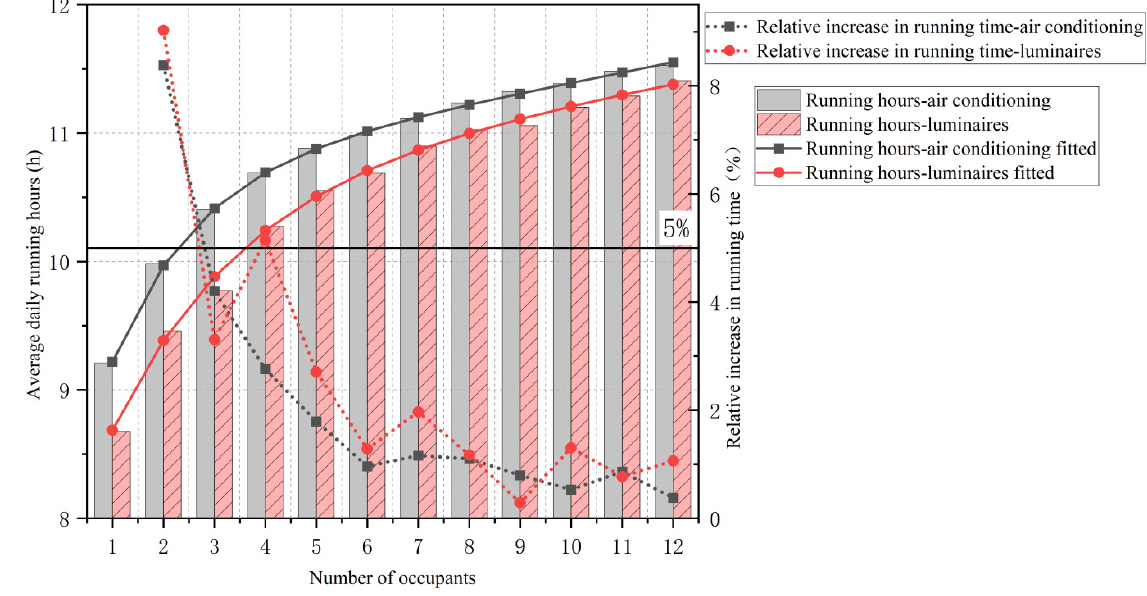
Figure 17. Influence of the number of office occupants on the average daily running time of equipment.